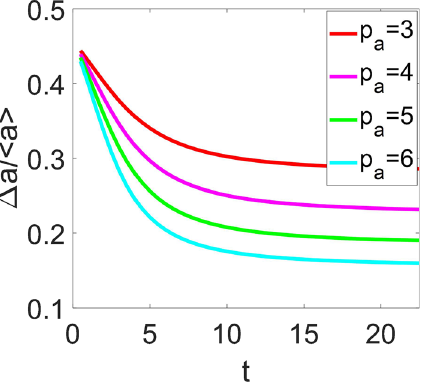
Fig. 14 Variations in the relative quantum fluctuation. The horizontal and vertical axes represent the time variable and relative fluctuation, respectively. The parameters are taken as: α = 0 . 5, V 0 = 200